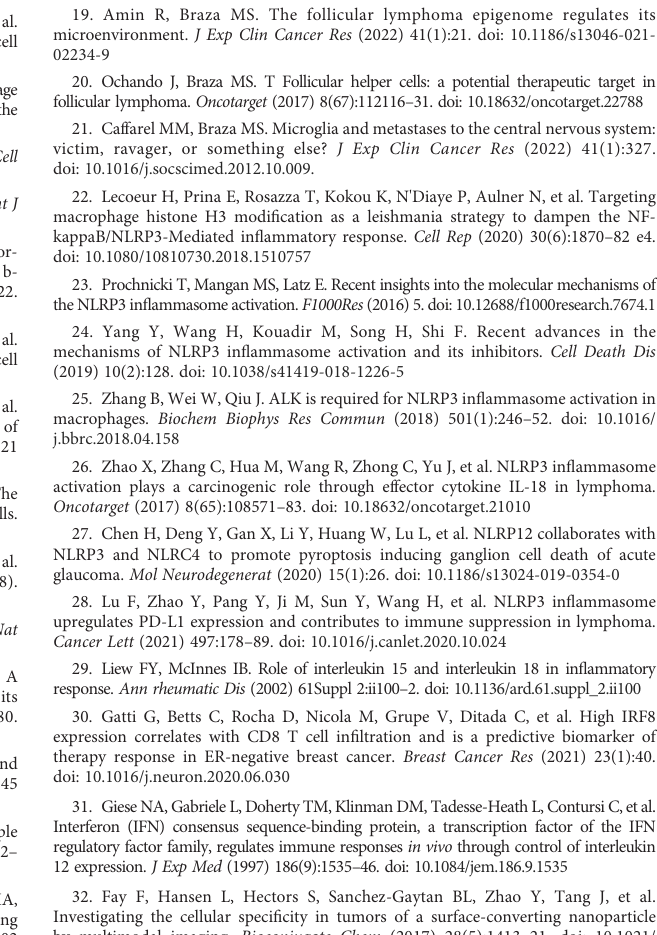
SUPPLEMENTARY TABLE 1 List of the characteristics of patients with DLBCL from the TCGA database. SUPPLEMENTARY TABLE 2 Manuallycuratedlistofthein fl ammation-relatedgenesusedinthisanalysisin DLBCLsamplesversusspleensampleswiththeirrespectivefoldchangeandP